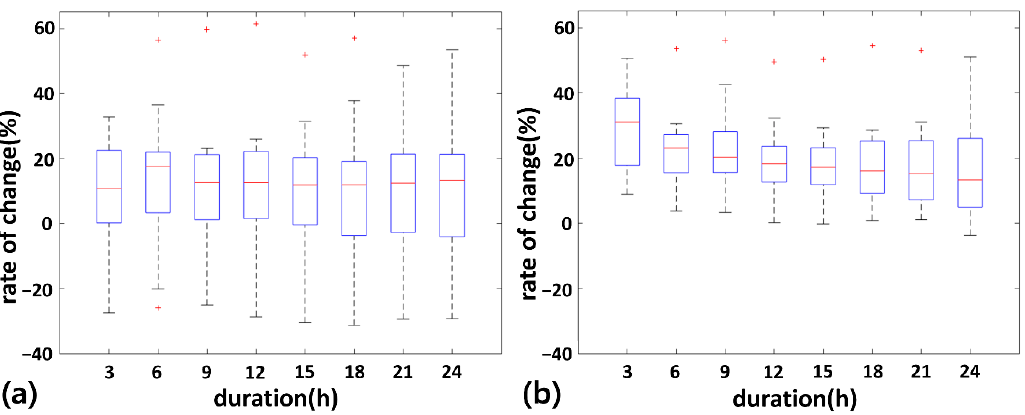
Figure 8. Boxplot of rate of change of 16 future design rainfall intensity ensembles with return period 30 years ( a ) at the Haenam site, and ( b ) at the Geumsan site. The blue box represents the inter-quantile range of the rate of change, and + means the outliers.